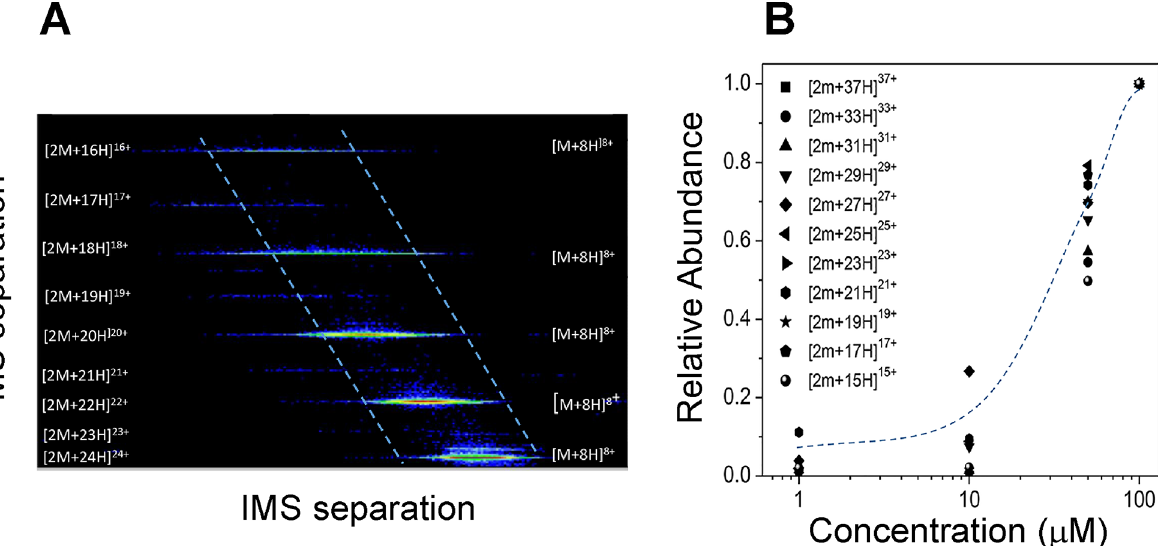
Fig 4. (A) A typical 2D IMS-MS contour plot showing the monomer and dimer signals at 100 μ M. Notice the overlap at even charge states in the MS domain for the monomer and dimer peaks. (B) Relative abundance of the dimer formation as a function of the concentration for the odd charge